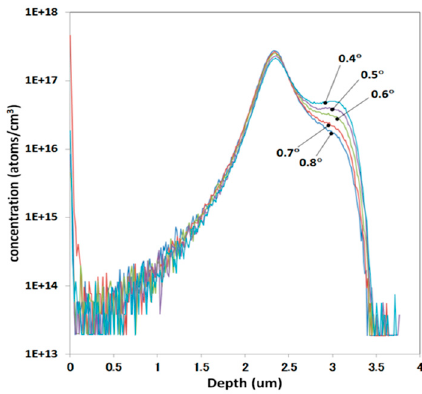
Figure 19. Secondary ion mass spectroscopy (SIMS) profiles implanted in 0.1° tilt steps [31]. Ion: B + ; Energy: 1.5 MeV; Dose: 1 × 10 13 cm − 2 ; Tilt: 0.4–0.8°.